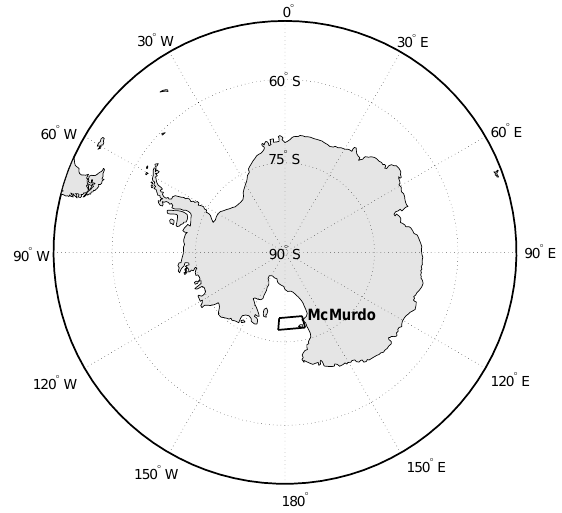
Fig. 1. The McMurdo Station, Antarctica, is located on the southern tip of Ross Island. The black box indicates the longitude/latitude span in which the sonde profiles plotted in Fig. 3 were